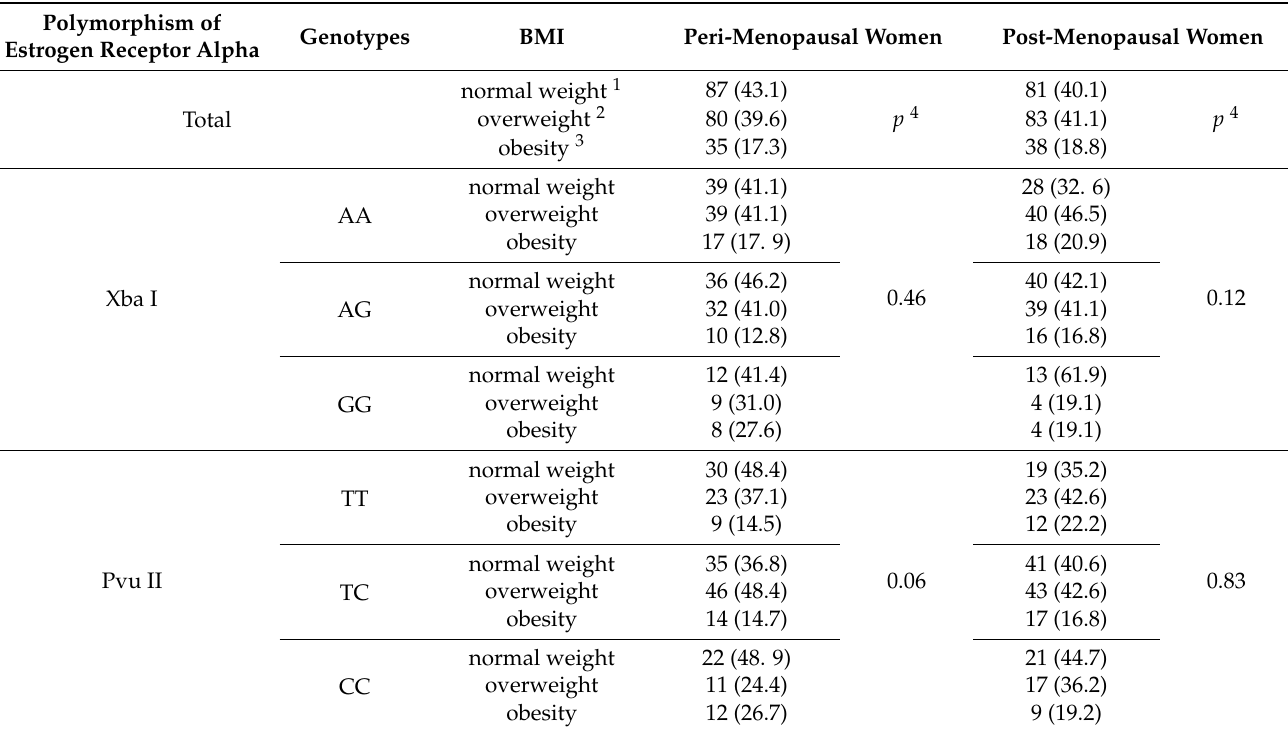
Table 3. BMI in peri- and post-menopausal women in total and by polymorphism of estrogen receptor alpha: Xba I and Pvu II.